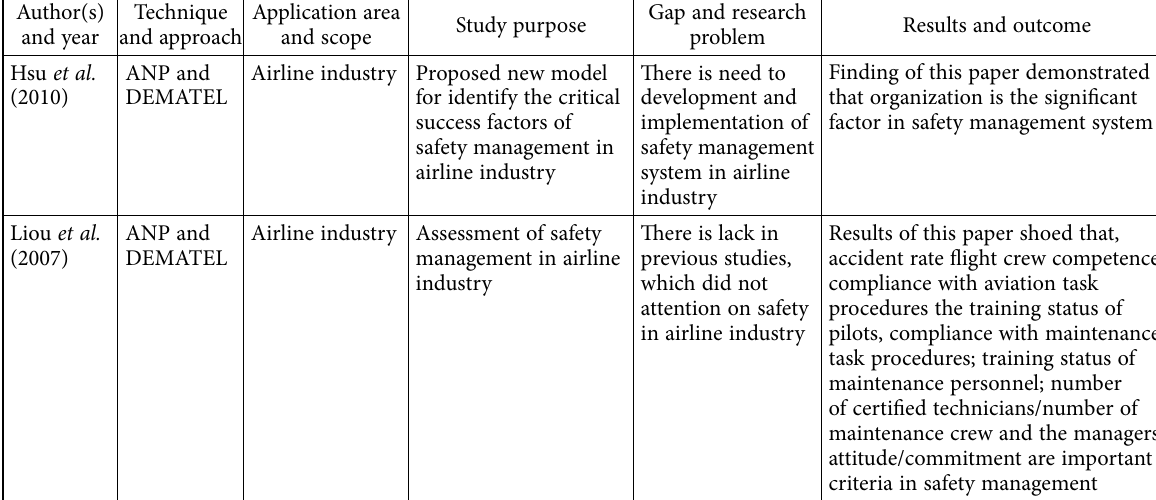
Table 10. Distribution based on integrated ANP, DEMATEL and fuzzy